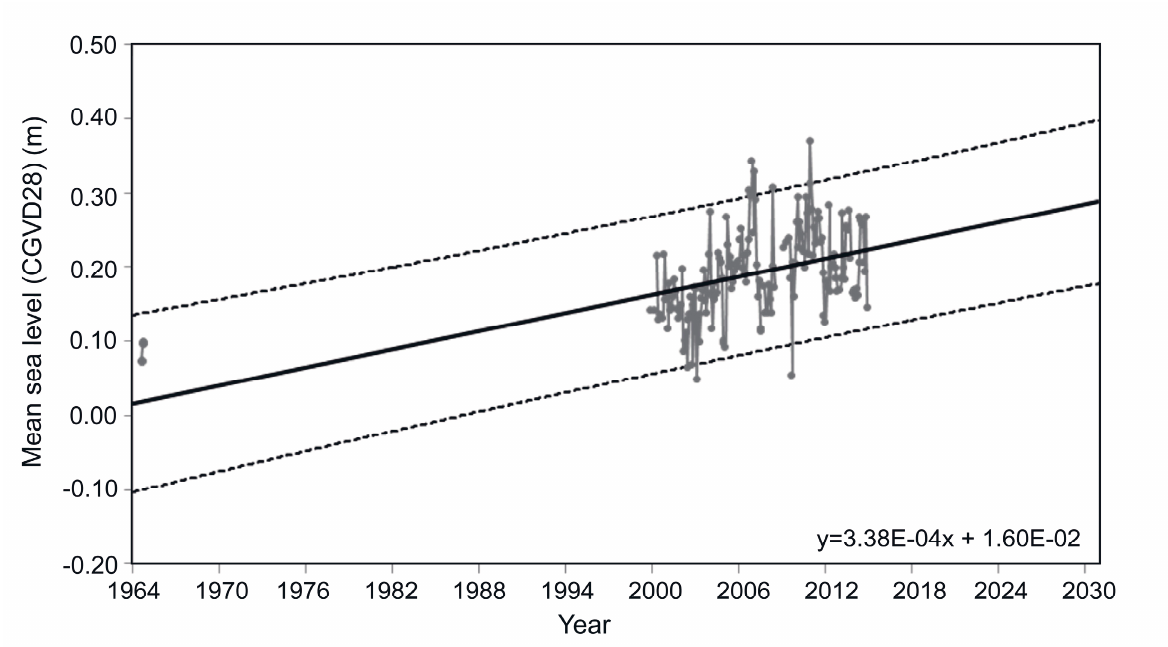
Figure 11. Linear model (solid line) fitted to 1964–2014 monthly mean sea levels at Belledune with 95% confidence bands. Linear term is statistically significant